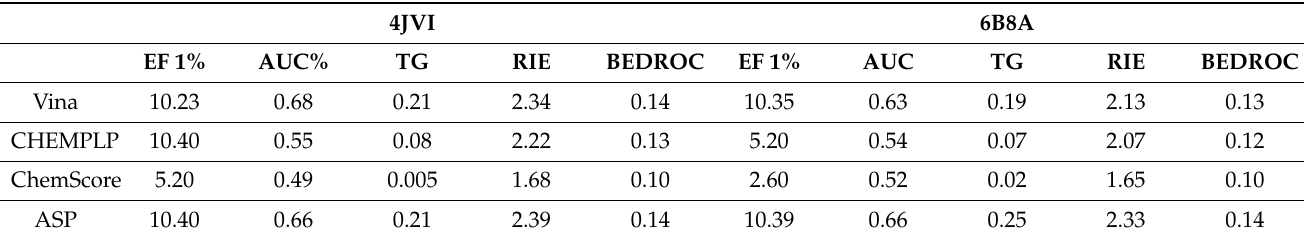
Table 2. Available X-ray structures of MvfR on the PDB and BSD.